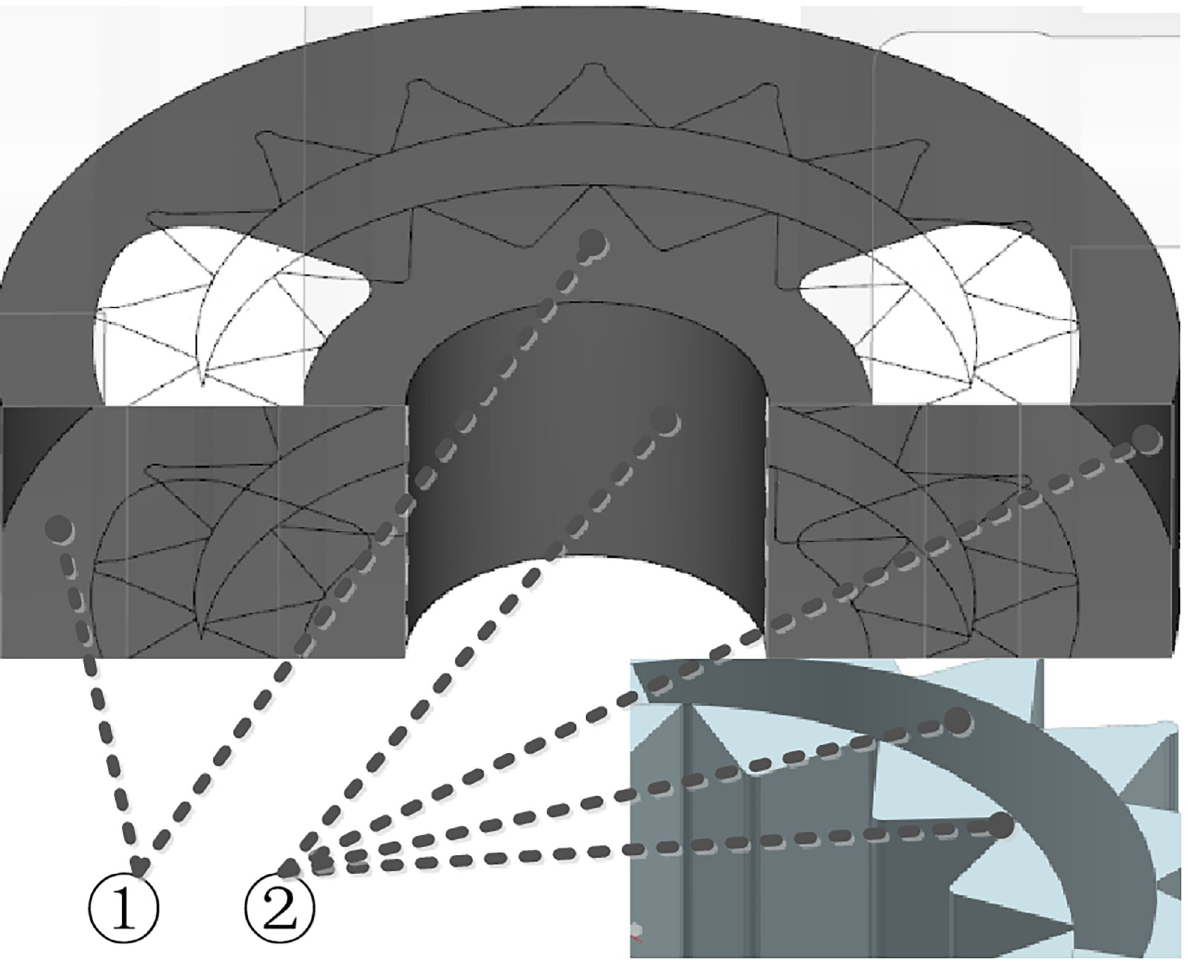
Fig 4. Solid model of internal leakage. ① Axial clearance ② Radial